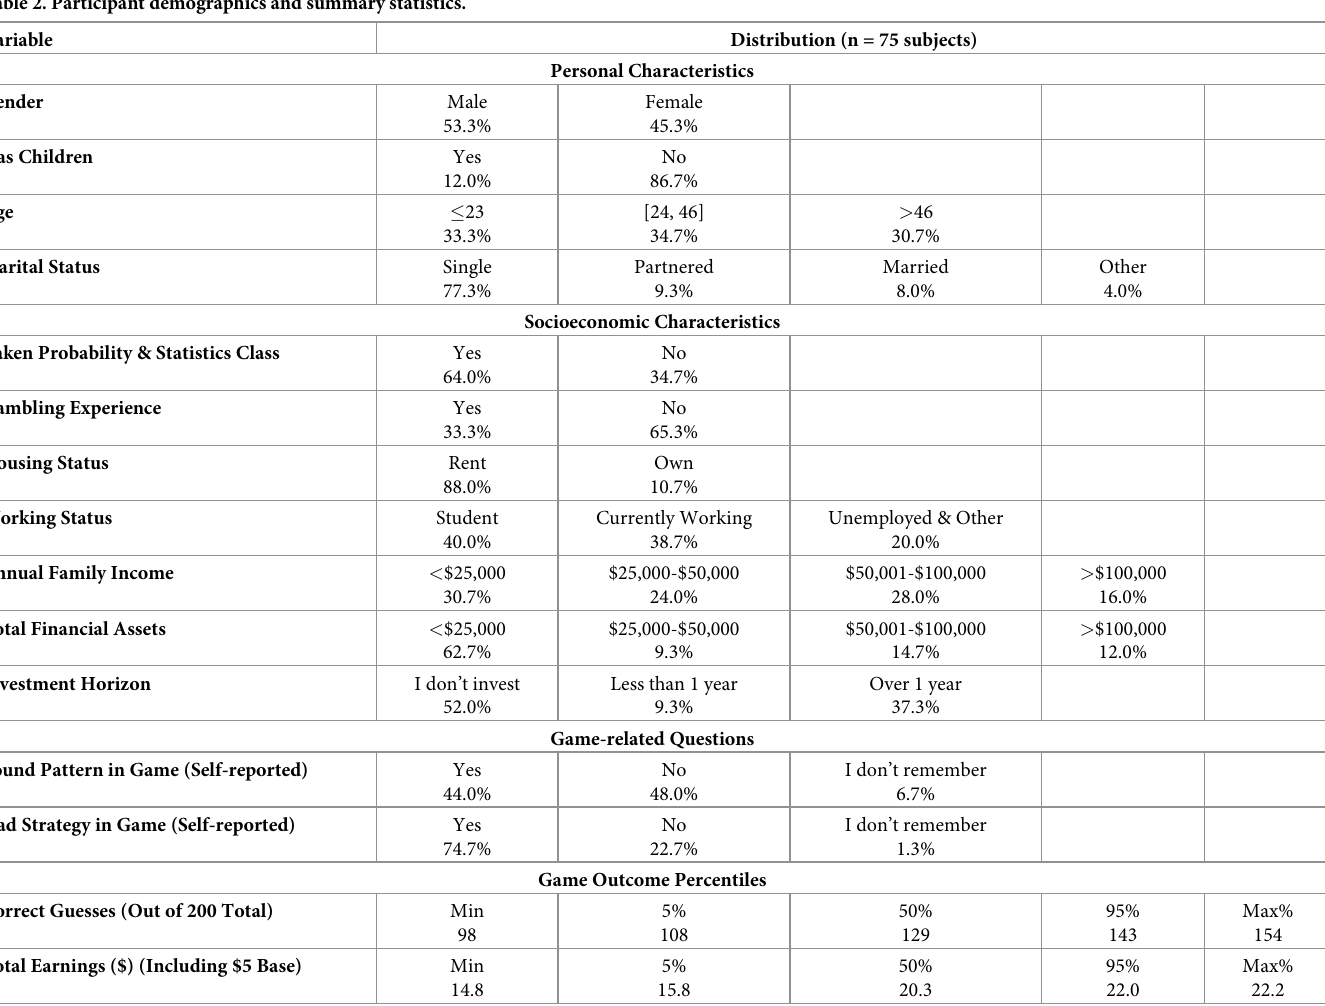
Table 2. Participant demographics and summary